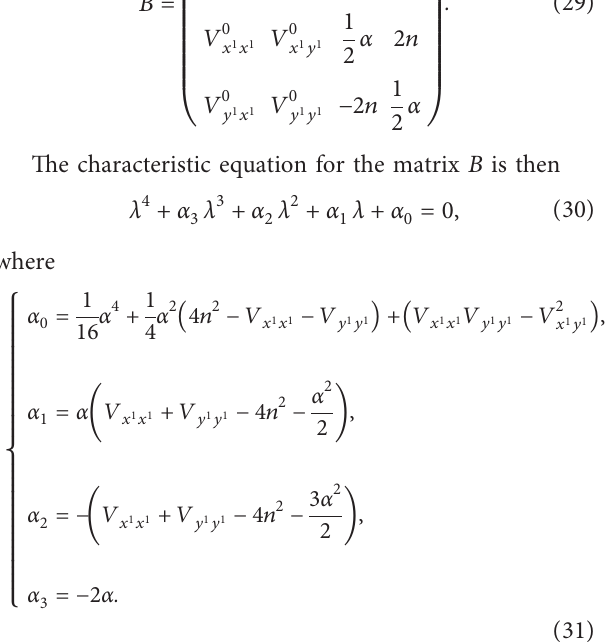
Table 1 represents the numerical solutions of equation � 0 . 90, q � 0 . 85, A � 0 . 03, (30), for the values T � 0 . 02, q 1 2 1 A � 0 . 02, M � 0 . 01, μ � 0 . 4, and α � 0 . 2 (Singh and Taura b 2 [24] and Ansari [16]) and three different values of